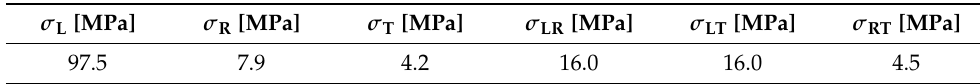
Table 2. Nominal strength properties of pine wood [27].